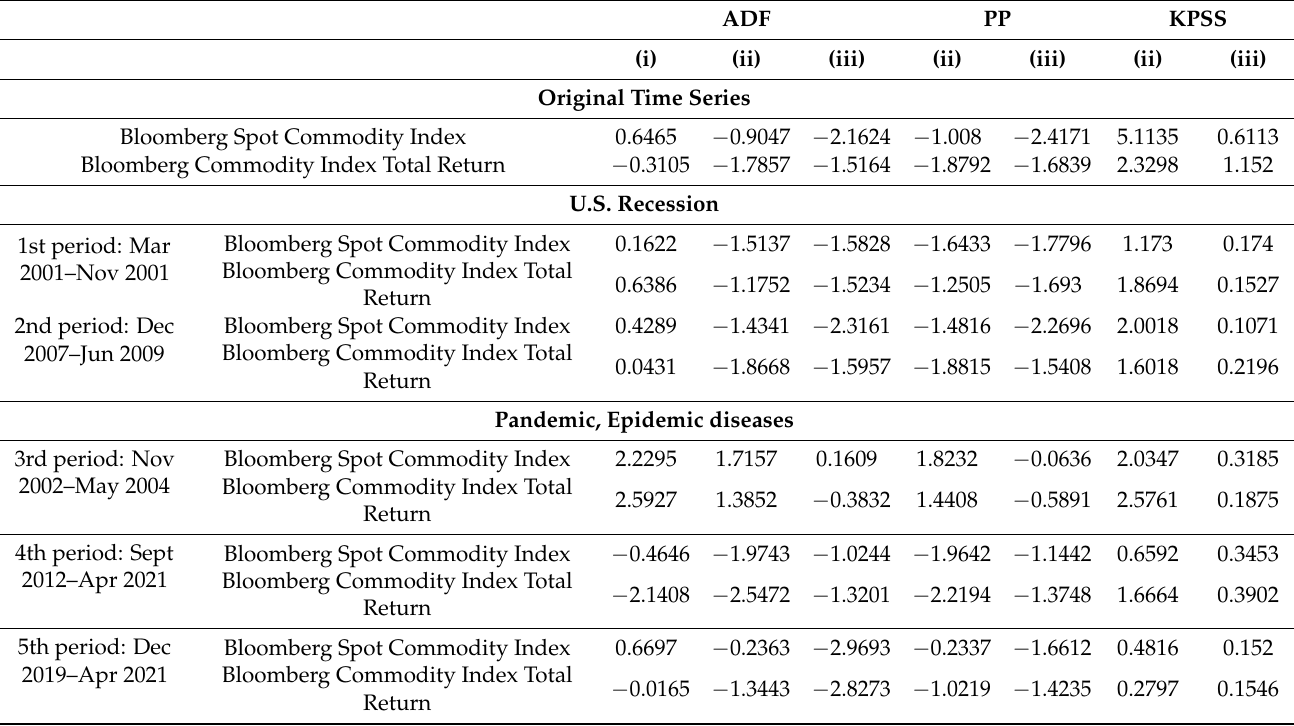
Table 2. Unit root